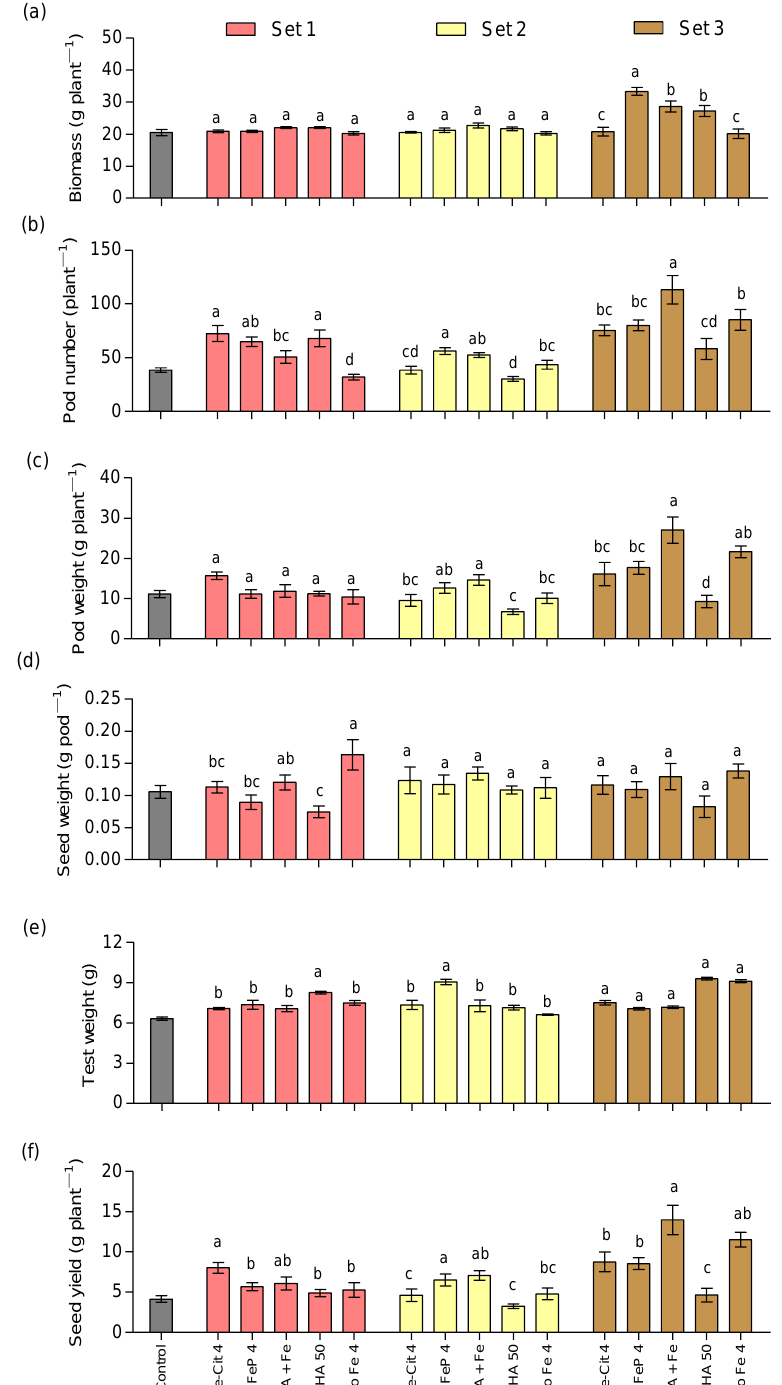
Figure 3. Influence of foliar application of Fe compounds on ( a ) total aboveground biomass, ( b ) number of pods, ( c ) pod weight, ( d ) seed weight pod −1 , ( e ) test weight, and ( f ) total seed yield of soybean. Data correspond to means ± SEm ( n = 5). The plants of set 1 and set 2 received single sprays in the flowering and pod-filling stages, respectively, while set 3 plants were sprayed in both stages. Each set was analyzed separately using a one-way ANOVA, and the least significant difference was calculated. Means with the same letter were not significantly different at p < 0.05. Details of the two-way ANOVA are presented in Table S2.